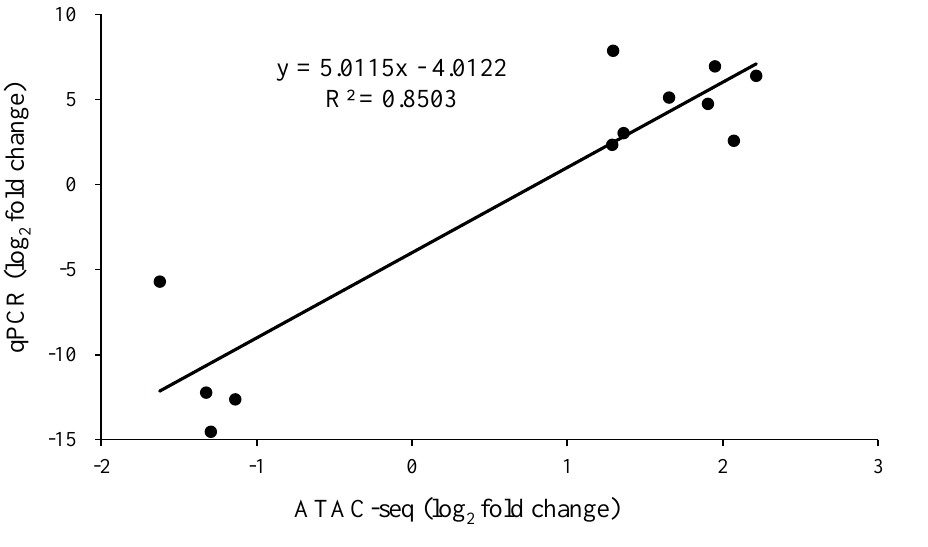
Figure 5. The comparison of differentially expressed peak-related genes in P. expansum between RT-qPCR and ATAC-seq data for the 12 selected genes. Fold-change values were converted to log2 (fold-change).